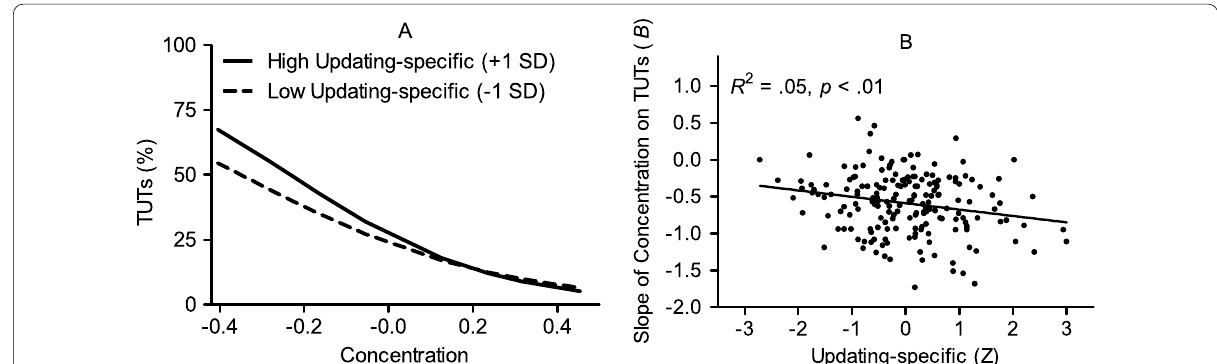
Fig. 3 Task‑unrelated thoughts (TUTs) as a function of the interaction between updating‑specific ability and momentary effort to concentrate on one’s current task ( N 187): A The model based on the hierarchical linear modelling. B A scatterplot of updating‑specific scores and slope = coefficients of concentration on TUTs based on within‑person ordinary logistic